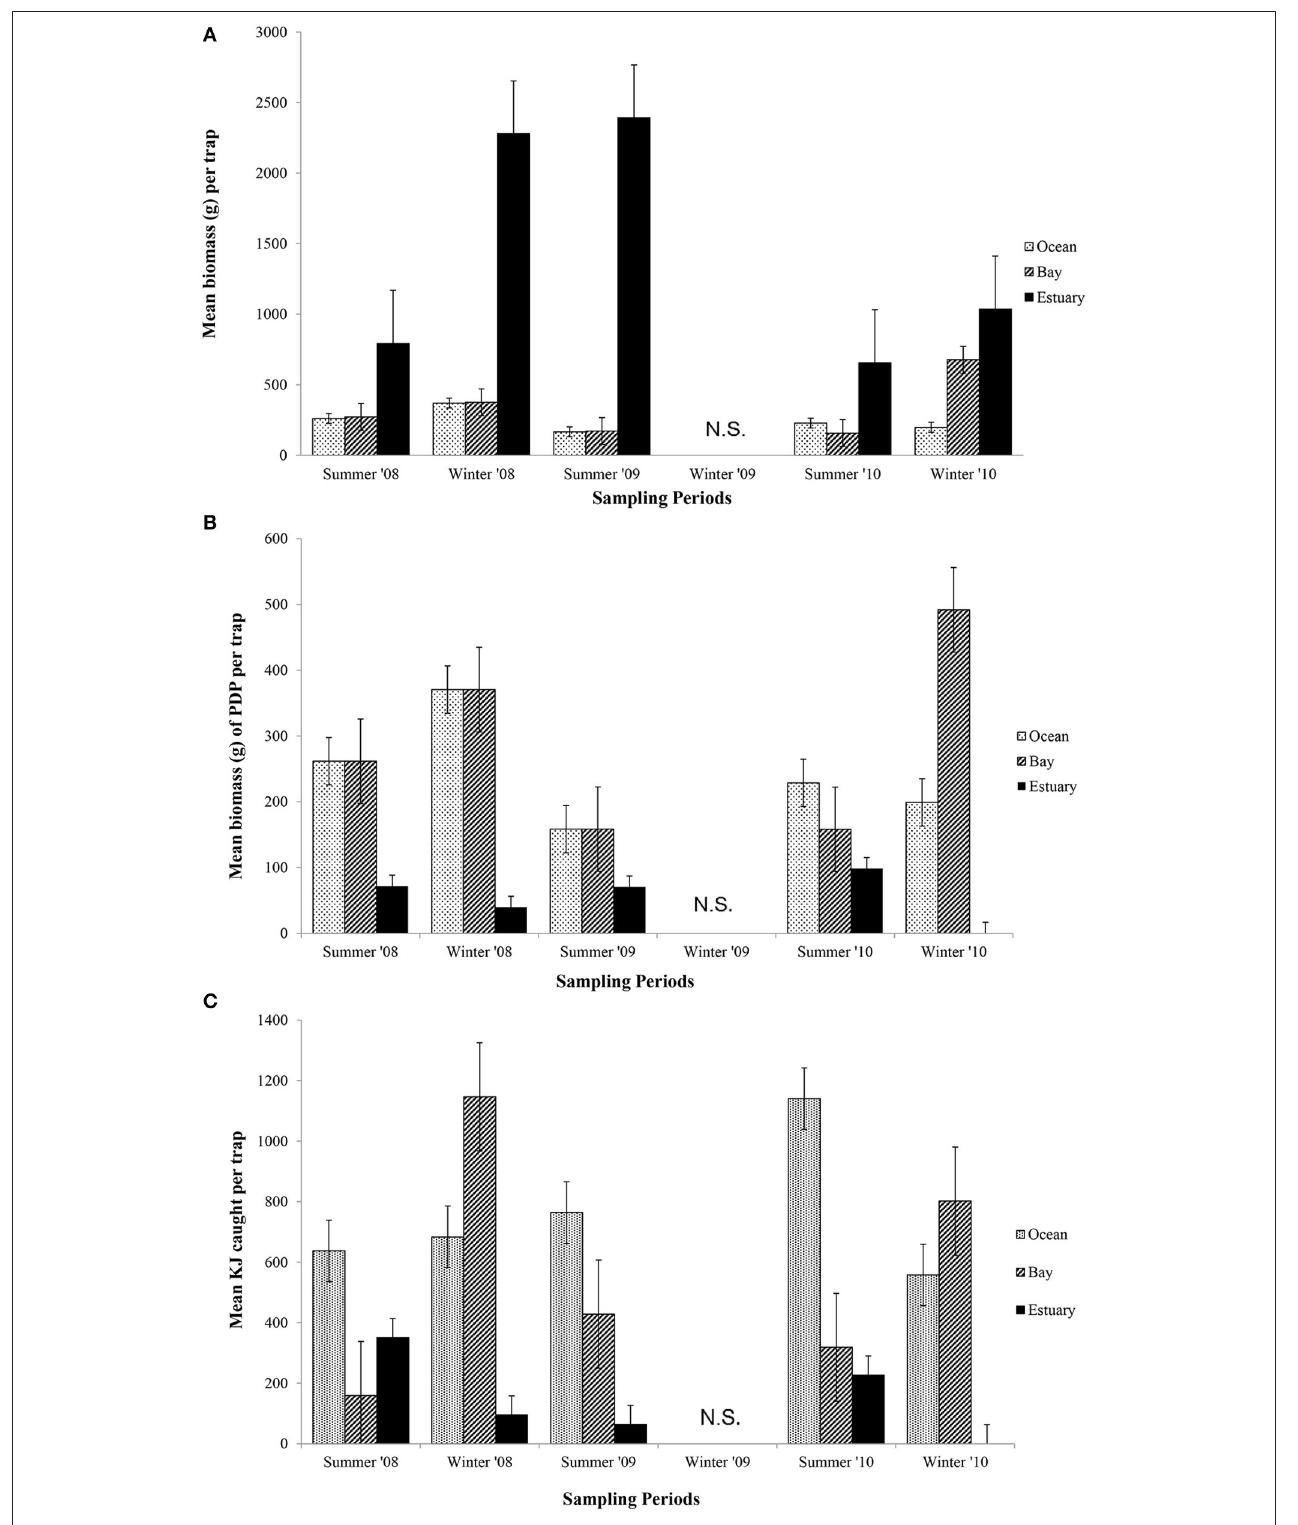
FIGURE 4 | Mean biomass ( ± 1 SE) of prey caught per trap for (A) total biomass; (B) biomass of PDP; and (C) KJ per trap in the Ocean, Bay, and Estuary. N.S. = Not Sampled.